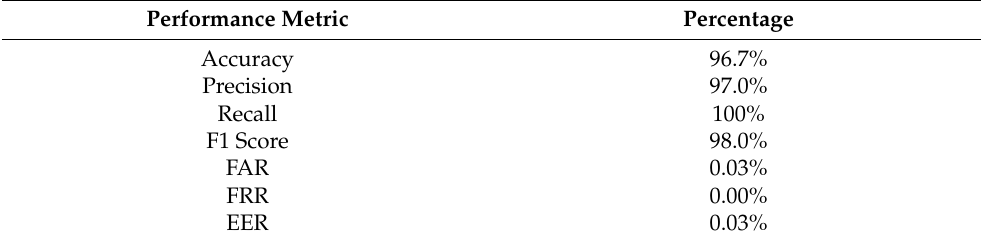
Table 6. Testing performance metrics by using raw signals as inputs in our UA